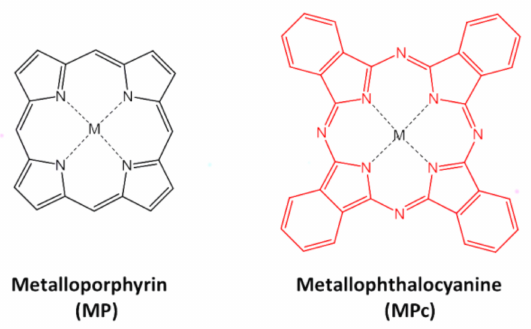
Figure 1. Molecular structure of MP and MPc